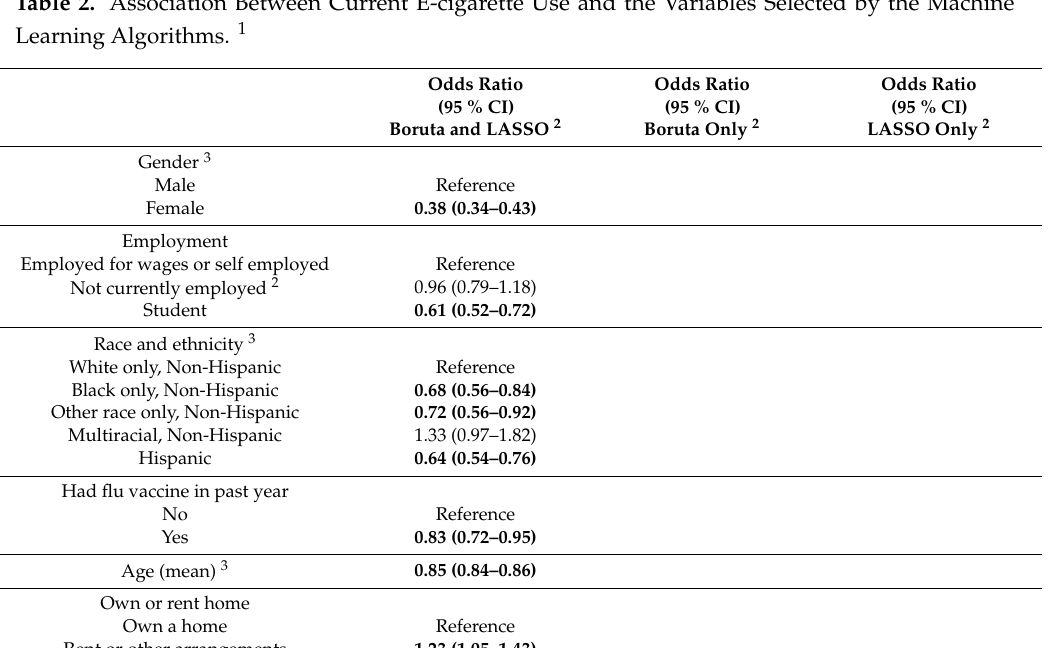
Table 2. Association Between Current E-cigarette Use and the Variables Selected by the Machine Learning Algorithms. 1